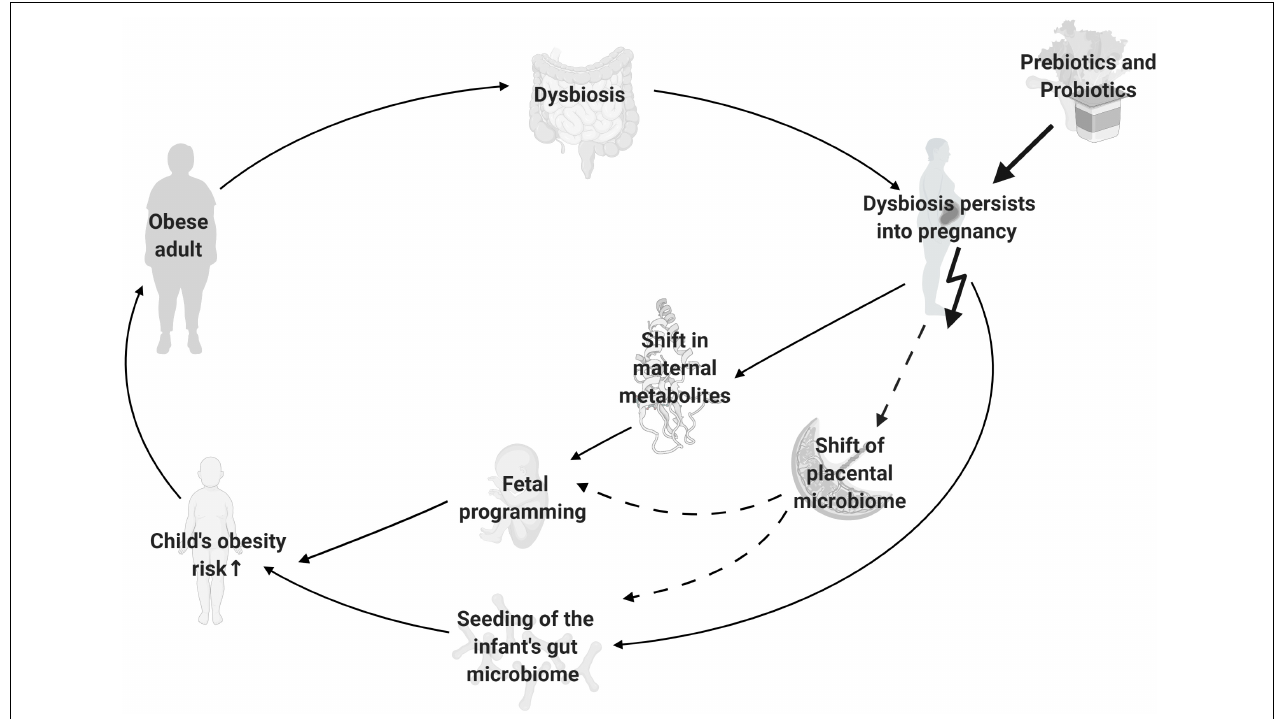
FIGURE 1 | Intergenerational cycle of obesity. Depicted are gut microbiome mediated factors, which increase offspring’s obesity risk in case of maternal obesity. Solid lines represent well established mechanisms, dashed lines represent possible mechanisms with controversial findings. The bold arrow represents the site where prebiotic and probiotic interventions are used to potentially interrupt the cycle. Created with